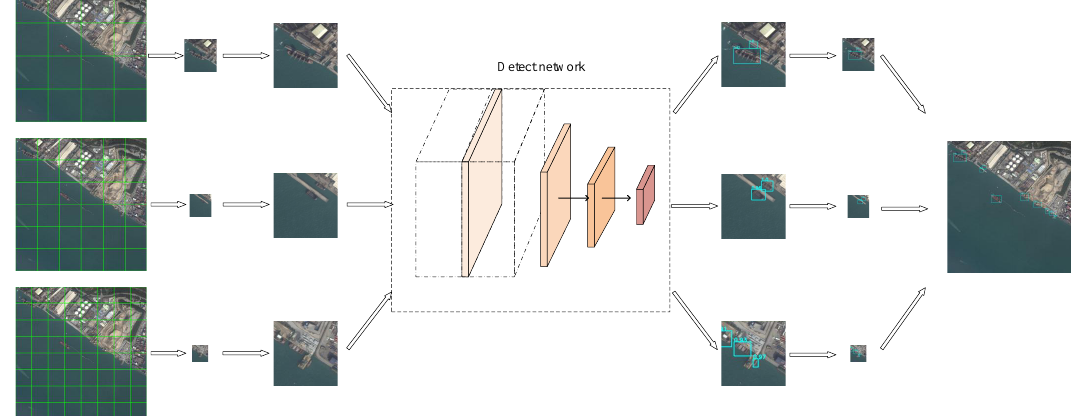
Figure 6. Flow diagram of the proposed multi-scale